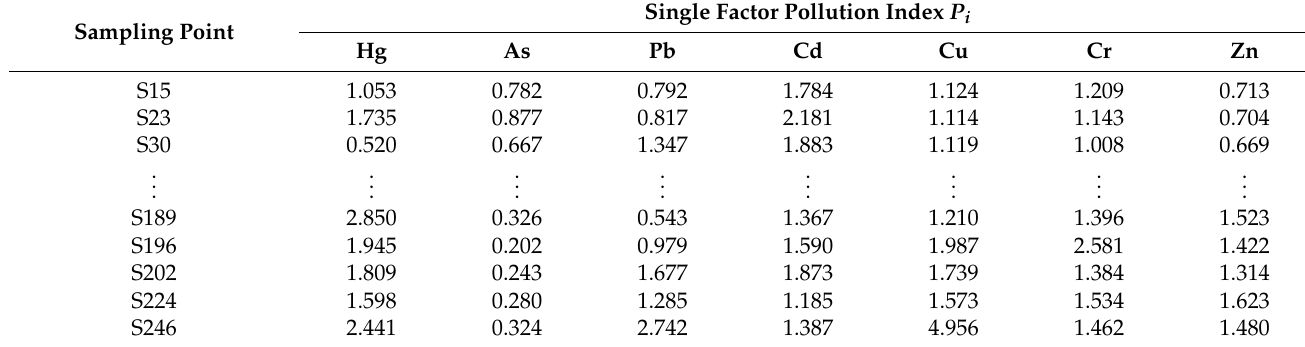
Table 7. Number of soil samples with various pollution levels based on five different evaluation methods.